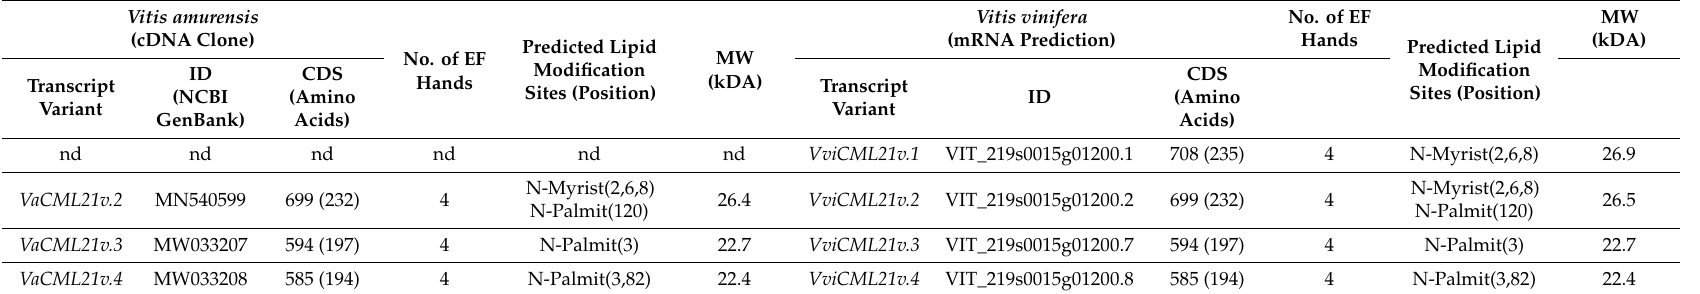
Table 1. Sequence characteristics of the CML21 mRNAs and their corresponding proteins in Vitis amurensis and Vitis